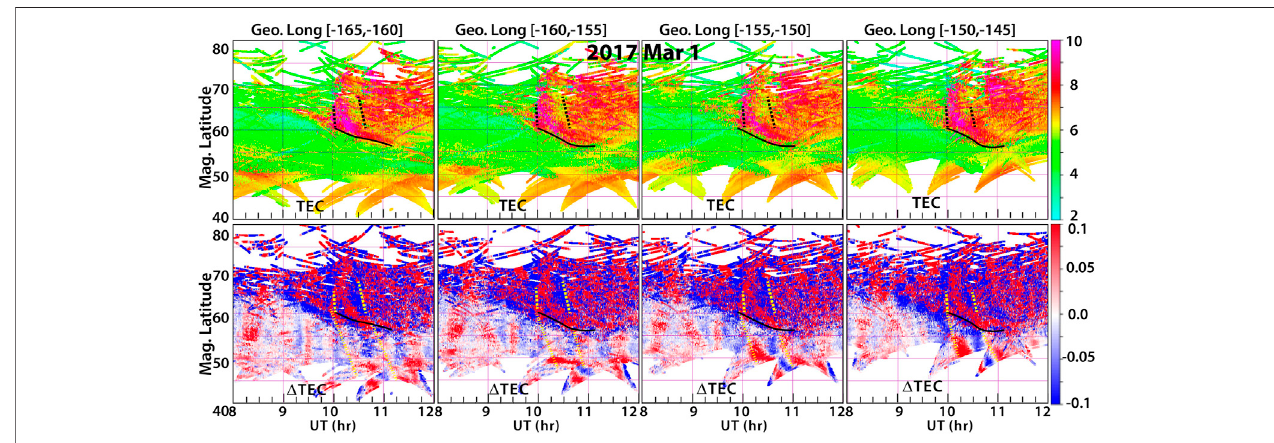
FIGURE 6 | Average TEC and Δ TEC over 5 ° geographic longitude increments from west of, to near, Poker Flat on March 1, 2017, in the same format as Figure 4